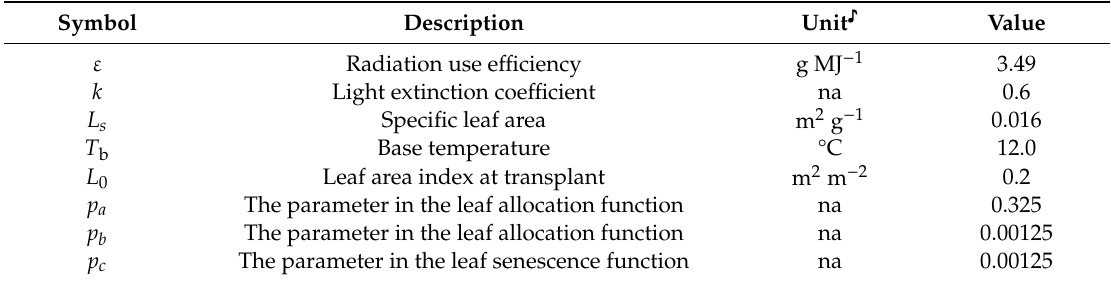
Table A1. Constant and parameter values used for the GRAMI-rice model